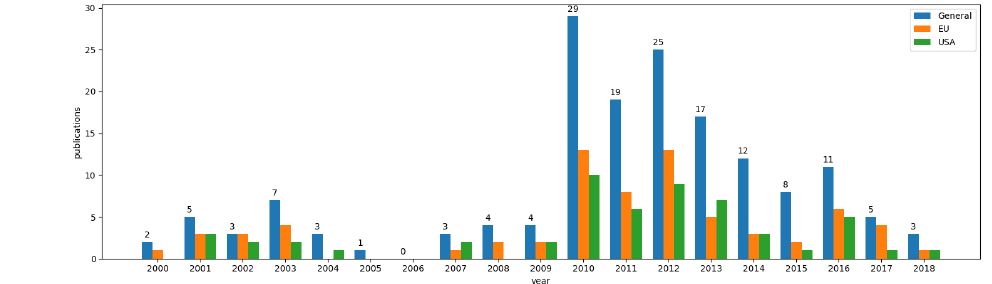
Figure 7. Comparison of papers chosen year by year: The blue line is the sum of all the papers that